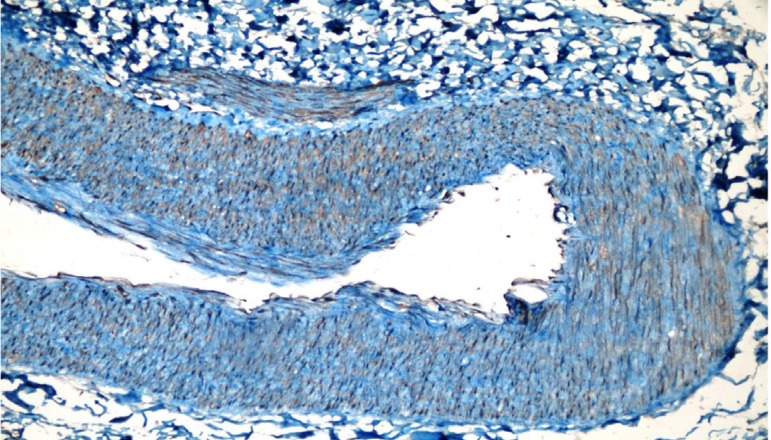
Endothelial nitric oxide synthetase (eNOS) of patient no. 22 (in the sharp dissection group) + endothelial damage (eNOS immunohistochemical staining of the transverse section taken from the radial artery sample) (eNOS immunoreactivity in endothelial cells +) (10×).